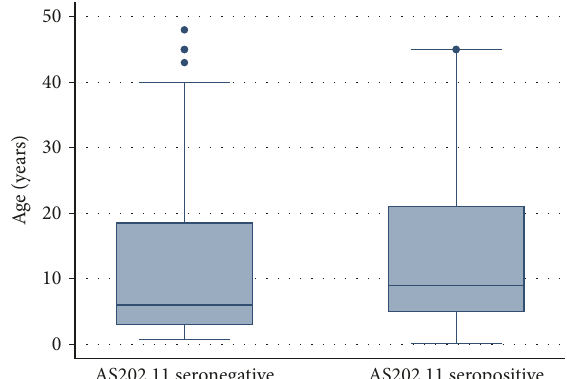
Figure 1: The relationship between AS202.11 seropositivity and age.